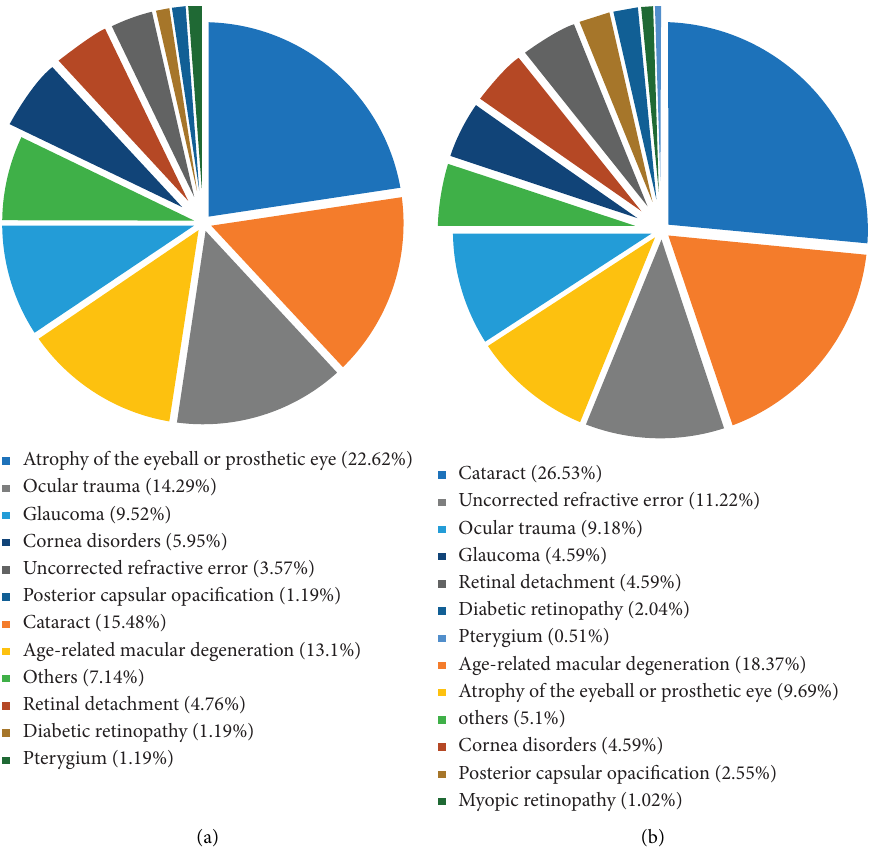
Figure 1: Te distribution of monocular presenting blindness causes using the WTO and US standards. (a) Monocular presenting blindness causes using the WTO standard; (b) monocular presenting blindness causes using the US standard. Table 4: Logistic regression analysis of associations of bilateral vision Impairment (20/400 ≤ presenting visual acuity < 20/60, better eye). Risk